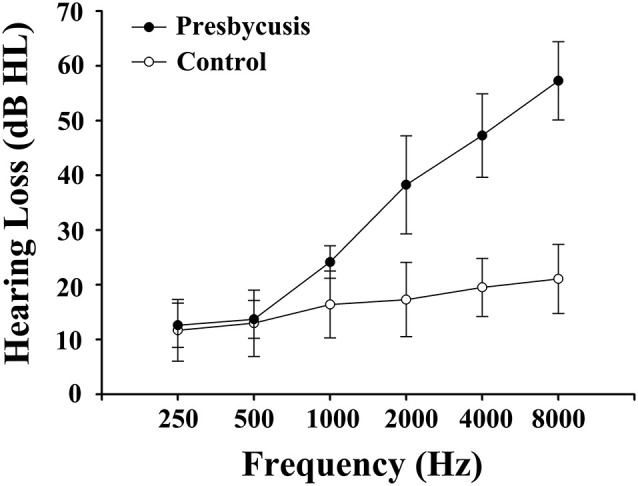
Mean hearing thresholds of the presbycusis and control groups from 250 Hz to 8,000 Hz. Data are presented as mean ± SD.